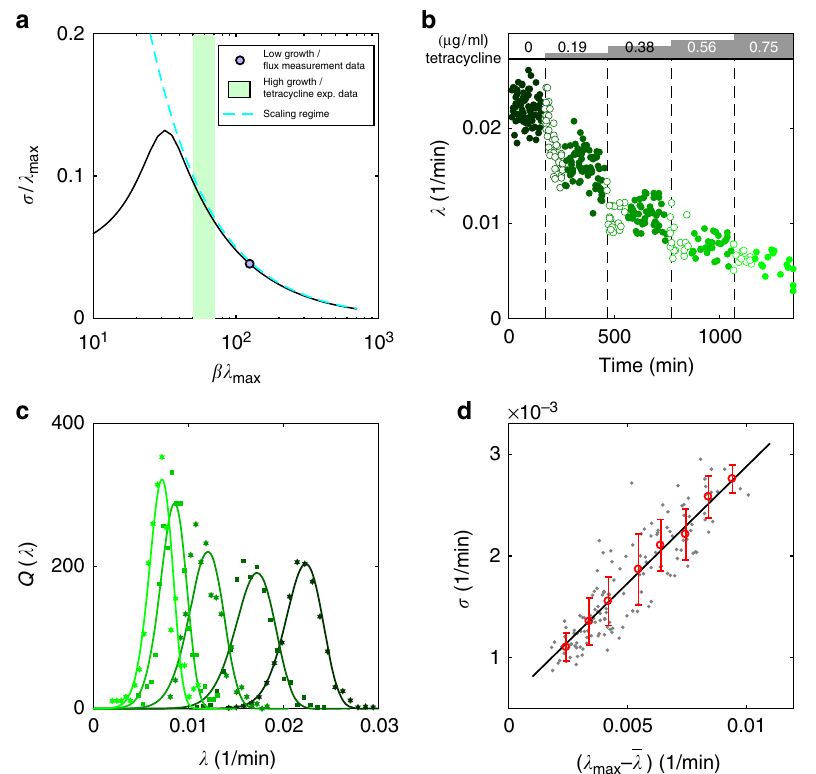
Fig. 4 a Predicted fl uctuations in the growth fl ux, σ / λ max , as a function of βλ max . Model inferred from data in Fig. 2a is shown as a blue point and the approximate range experimentally probed in b – d is shown as green shade. In the scaling regime (cyan dashed line), σ ∝ ( βλ max ) − 1 . b single-cell measurements (each dot = one division event) of elongation rate in a micro fl uidic mother machine device for wild-type E. coli under increasing sub- inhibitory antibiotic concentrations, indicated on top; data from a single experiment in ref. 37 . After switching to higher antibiotic concentration (lighter shade of green), cells show transient behavior (empty green circles) which we ignore and focus only on steady state (full green circles). c Measured distributions (plot symbols) of growth rates from multiple experiments as in b (different shades of green = different tetracycline concentration). Solid lines show maximum entropy distributions with best- fi t values for ( β , λ max ) (Supplementary Note 3). d Testing the predicted scaling of growth rate fl uctuations. Each dot = one lineage from experiments in c . The average growth rate, (cid:1) λ , the maximal observed growth rate, λ max , and the SD of the growth rates, σ , were estimated separately on each lineage. Scaling regime of a predicts a linear relationship, which is shown here by binned data (red points with errorbars = mean ± SD within equi-distant bins) and best linear fi t (solid black line, R 2 =